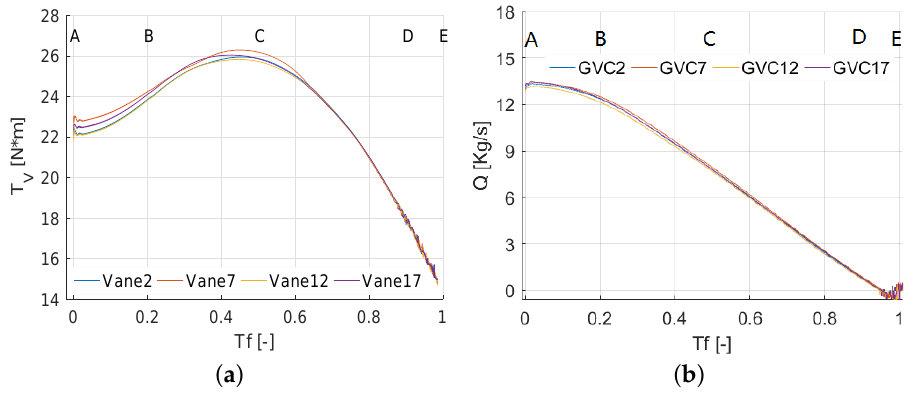
Figure 19. ( a ) Trend of torque on different guide vanes; and ( b ) mass flow in different guide vane